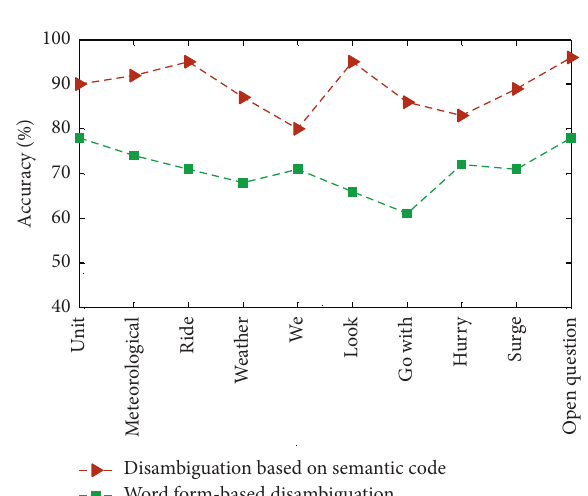
Figure 4: Corpus distribution.